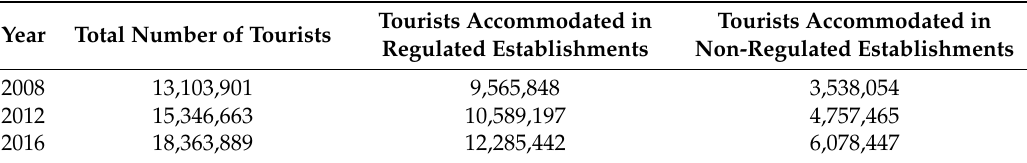
Table 1. Evolution of the number of tourist arrivals to the Balearic Islands as per type of accommodation. Years 2008, 2012 and 2016.